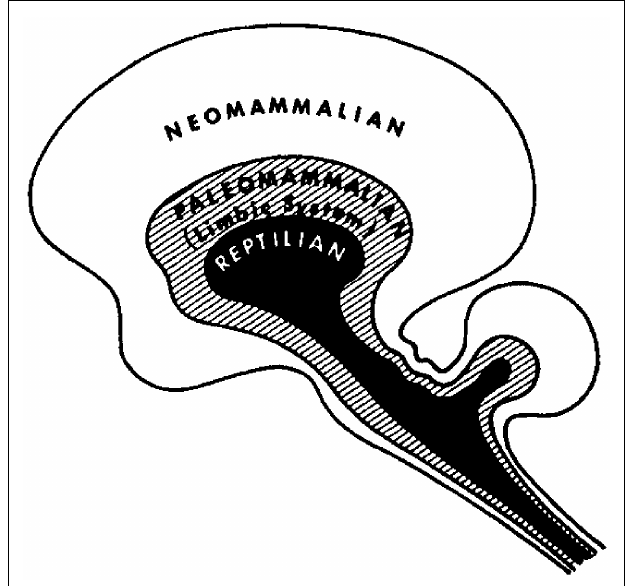
FIGURE 2 |TheTriune Brain Model by MacLean (1990). Image courtesy of